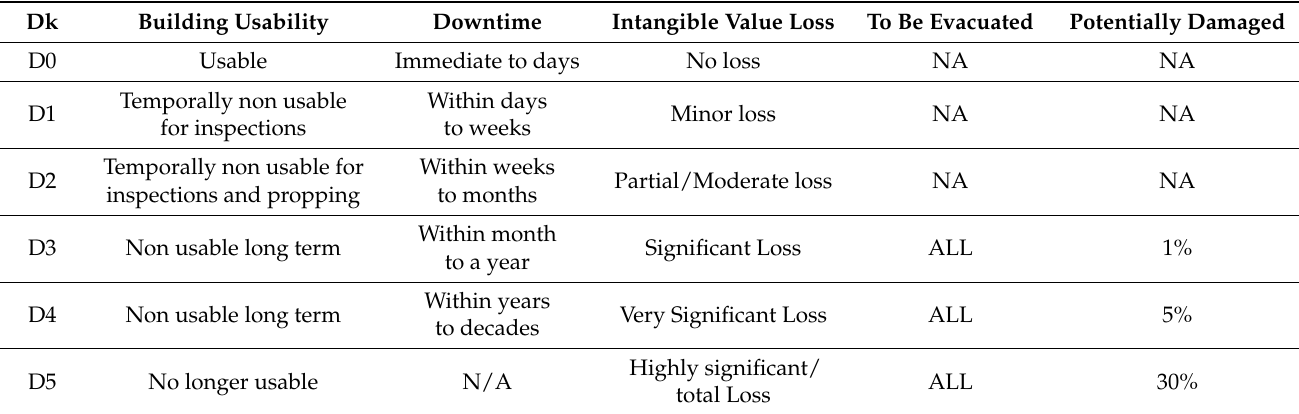
Table 10. Assumed correlation between physical damage level Dk, the residual building usability and downtime, impacts on the artworks and loss of intangible value.